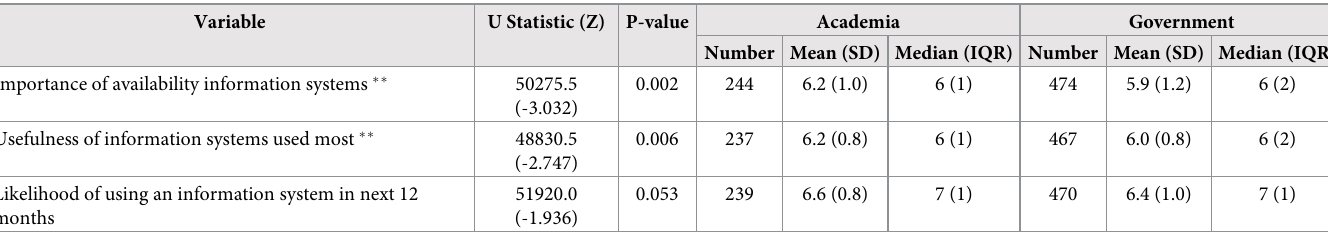
Table 15. Mann-Whitney U tests of importance, usefulness, and likelihood of using a web-based information system.